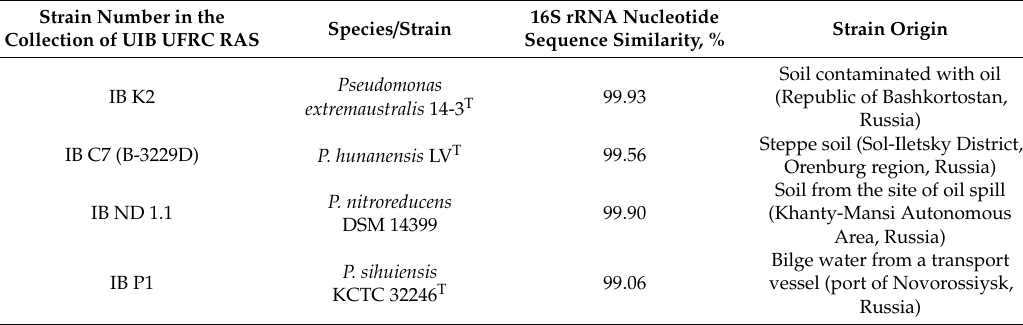
Table 1. Species a ffi liation and origin of bacterial strains used in the